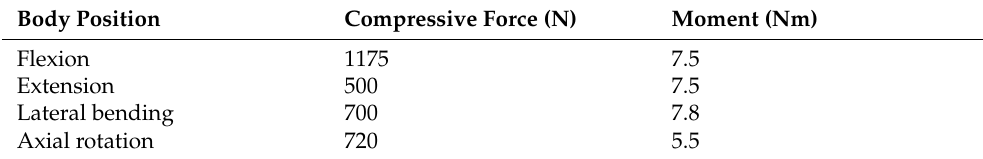
Table 2. Loading conditions for simulated motions of a lumbar spine [29]. Body